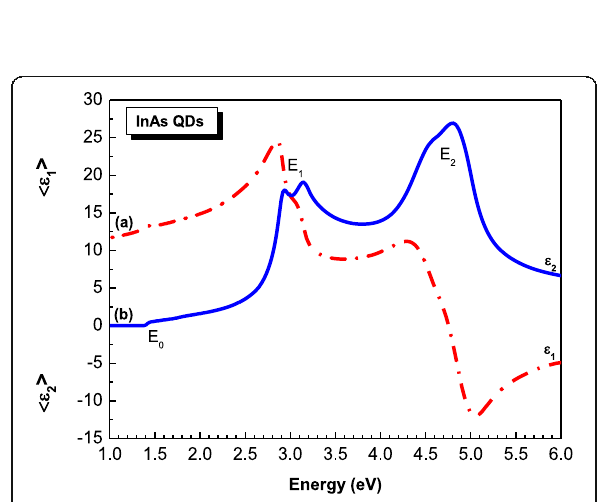
Fig. 2 Real ( ϵ 1 ) ( dashed red line ) and imaginary ( ϵ 2 ) ( solid blue line ) parts of dielectric functions of the InAs/InGaAs QD heterostructure obtained from SE measurements [10]